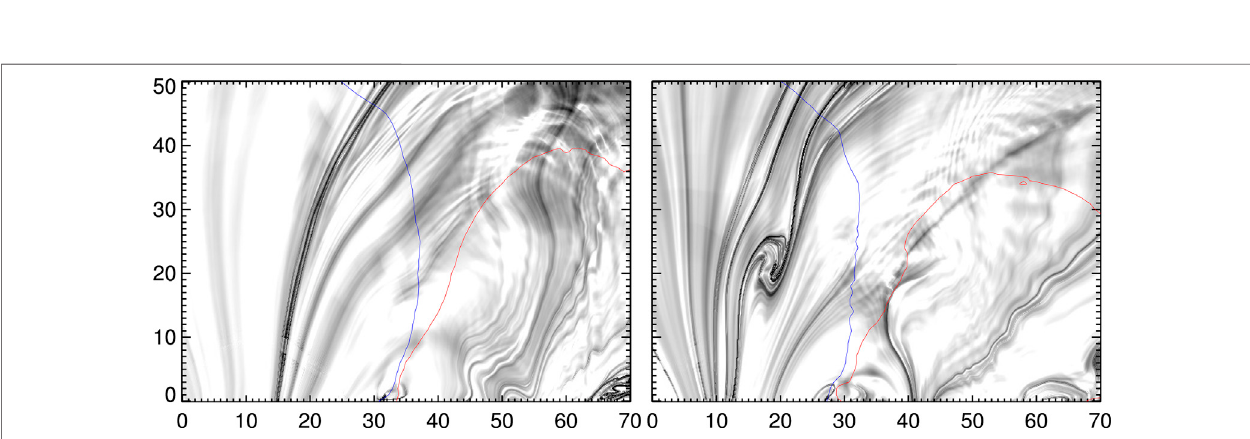
Frontiers in Physics |